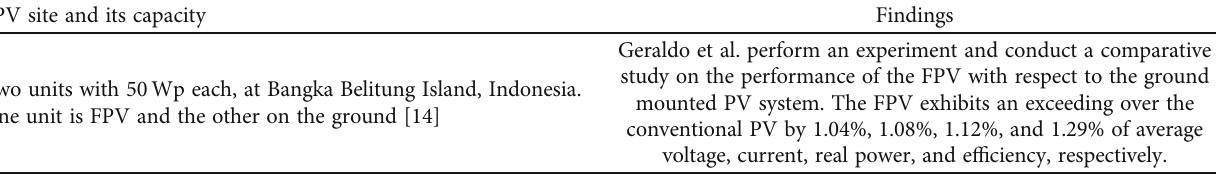
Table 1: Summary of related works on FPV